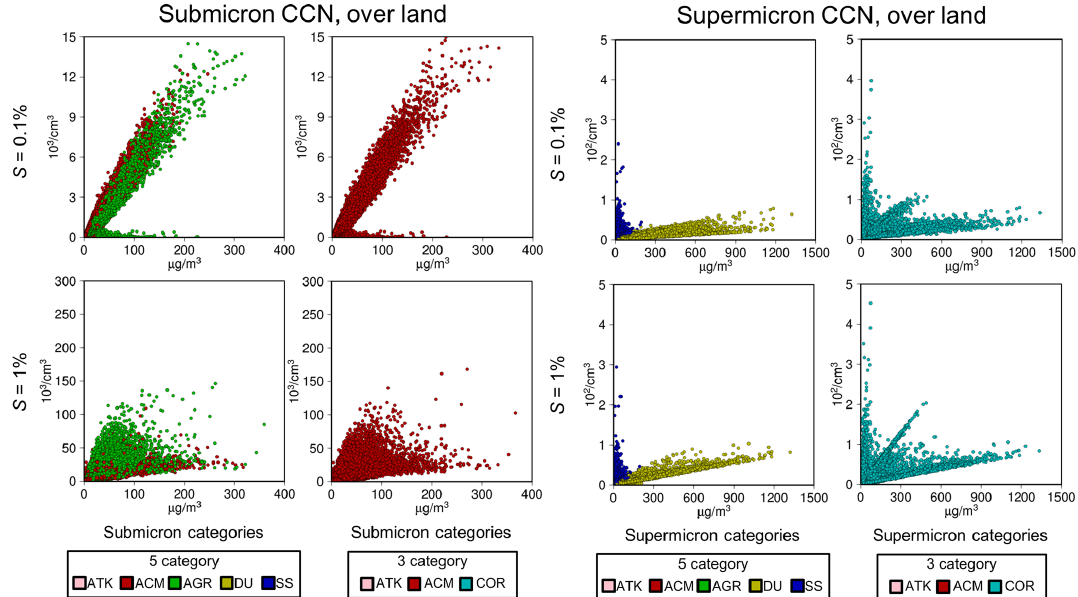
Figure 13. Scatter diagrams between the daily mean, averaged below 1kma.g.l., CCN number concentration ( y axis) over the land grids at supersaturation of (top) 0.1% and (bottom) 1% from (left four panels) submicron categories (i.e., ATK, ACM, and AGR for the five- category method and ATK and ACM for the three-category method) and (right four panels) supermicron categories (i.e., DU and SS for the five-category method and COR for the three-category method). The x axes are the total dry mass concentrations of the submicron (left four panels) and supermicron (right four panels) categories. The colors of the dots correspond to those of the categories in the legends with the most dominant mass concentrations of the grids.